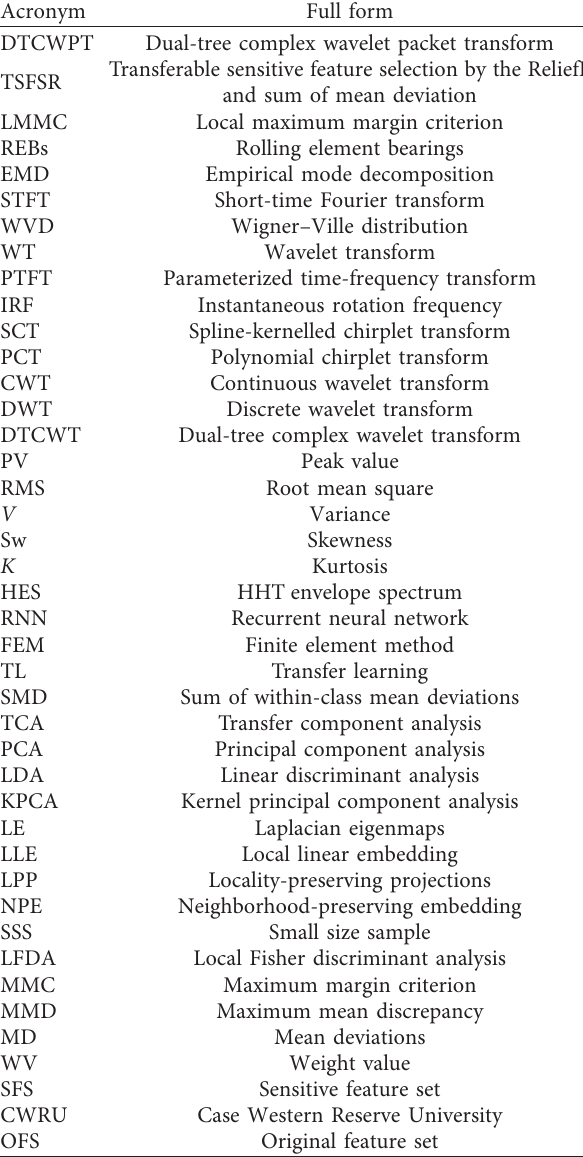
Table 1: A list of acronyms used in this